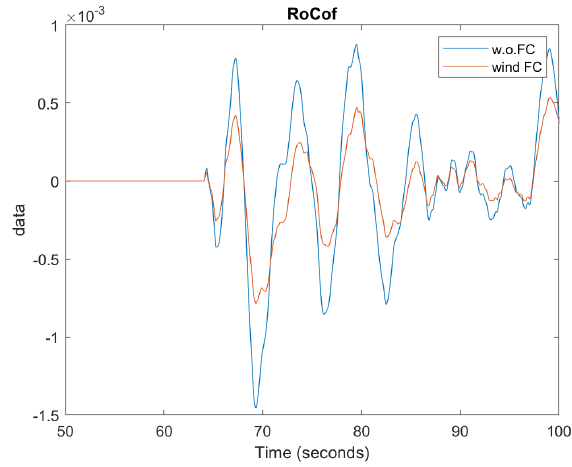
Figure 19. Simulation 6 RoCoF.